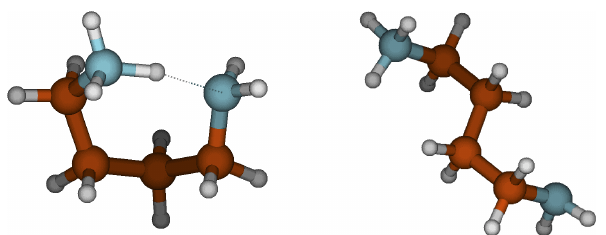
Figure 3. Cyclic and acyclic configurations of protonated PUT. The lowest energy acyclic structure is 14.6kcalmol − 1 higher in free en- ergy than the cyclic, global minimum structure.